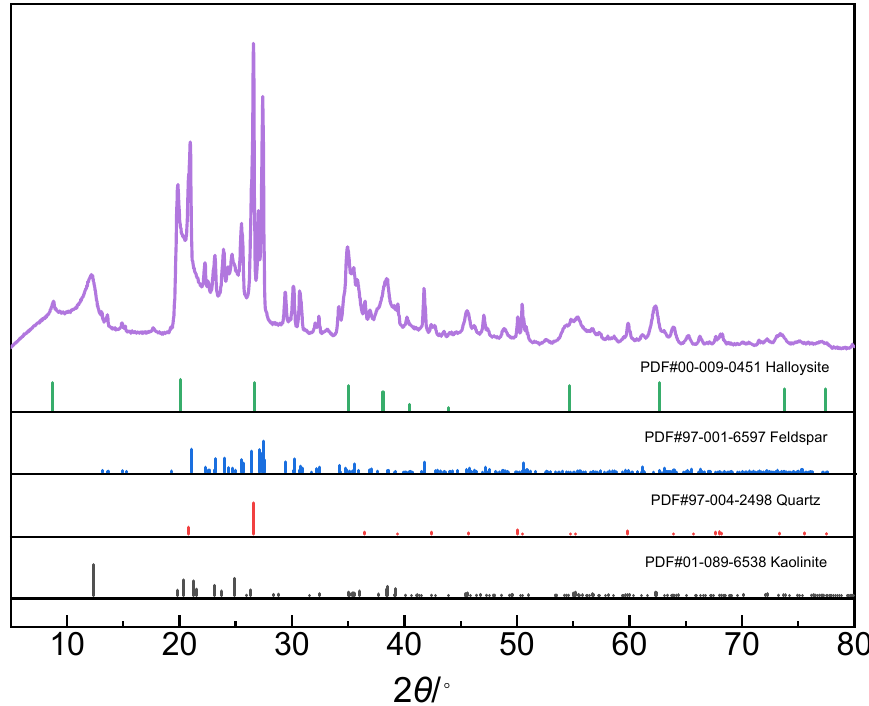
Figure 1. The oxides contained in the rare earth ore samples were Al 2 O 3 (34.975%), SiO 2